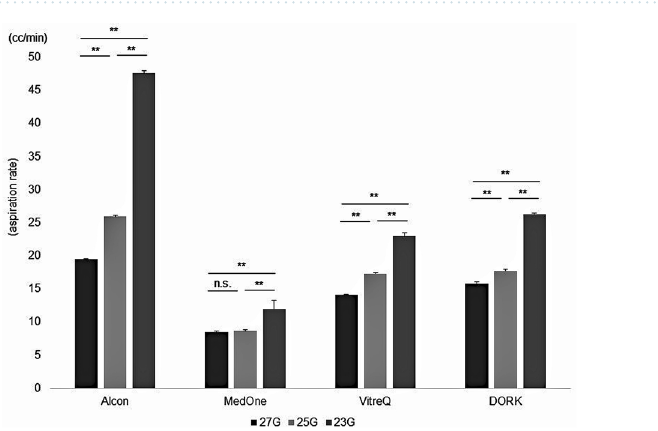
Figure 2. Comparison of aspiration rate (AR) under the condition of ethylene glycol aspiration. AR decreased significantly as the aspiration vacuum level decreased in 23G and 25G products in each company. In 27G product, AR decreased significantly as the aspiration vacuum level decreased in Companies A and D (** p < 0.01). 27G product from Company B (VitreQ) was unable to aspirate ethylene glycol at all at an aspiration vacuum level of 100 mmHg. In addition, 27G product from Company C (MedOne) could not aspirate ethylene glycol at all at the aspiration vacuum levels of 100 mmHg and 200 mmHg. ( A : 27G, B : 25G, C : 23G).